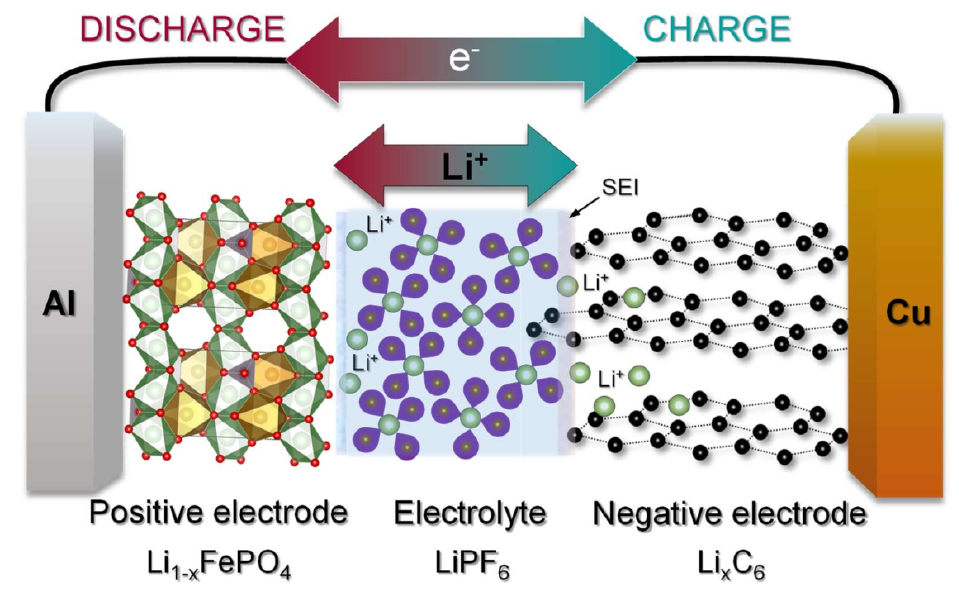
Figure 1. A schematic representation of the basic principles of operation of rechargeable LIBs utilizing lithium hexafluorophosphate (LiPF 6 ) as conventional electrolytic salt. The latter is typically dissolved in organic-based solvent mixtures (e.g., ethylene carbonate/diethyl carbonate) representing a class of electrolytic solutions which play a key role in the process of suitable SEI layer formation on the negative electrode. Note that also other types of electrolytic salts and organic solvents could be employed to obtain electrolytic solutions with different physiochemical